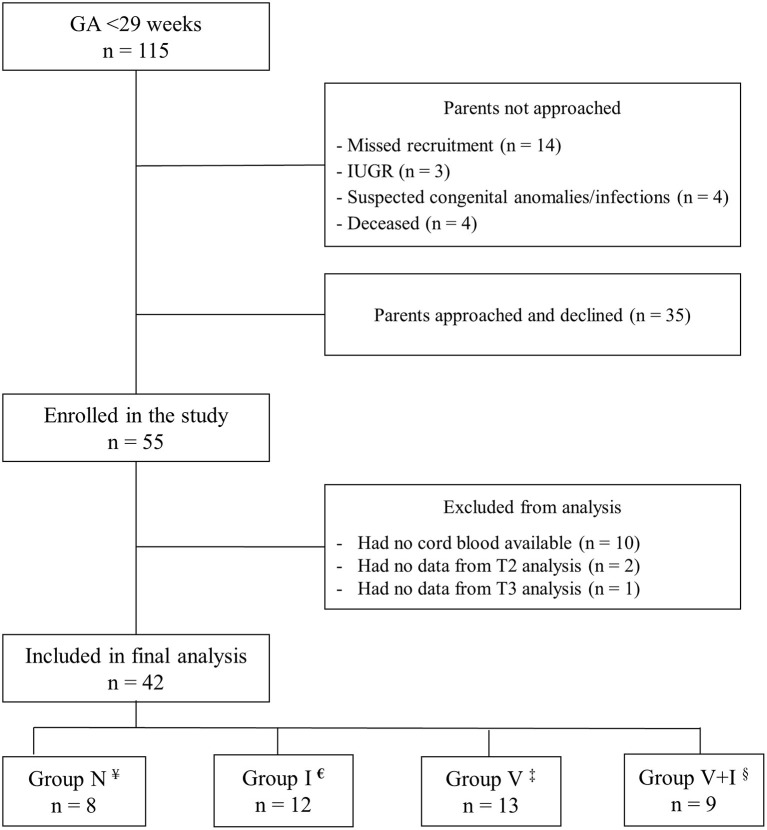
Flowchart of enrollment. ¥Normal placenta,€Placental inflammation, ‡Placental vasculopathy changes, §Combined vasculopathy and Inflammation changes.